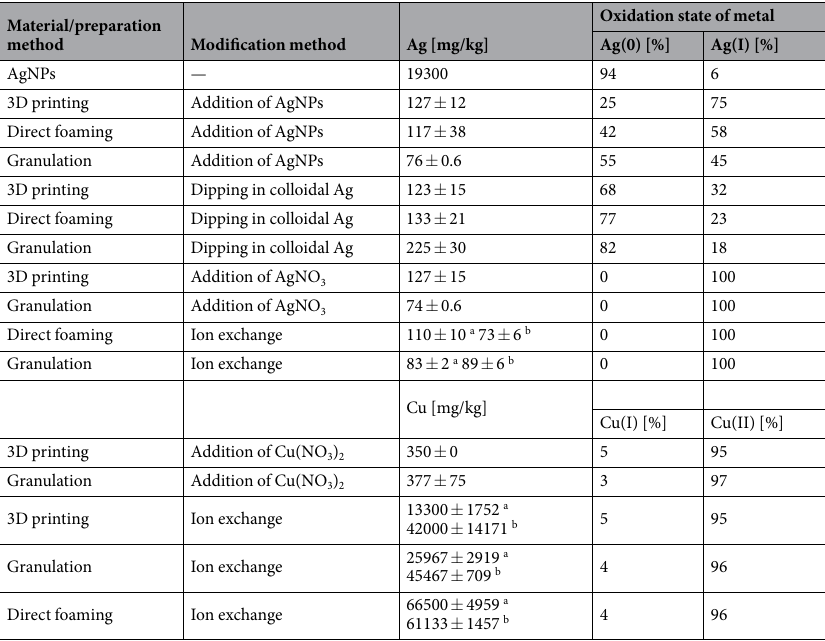
Table 2. Ag and Cu content and oxidation state in the modified filters, as determined by X-ray photoelectron spectroscopy (XPS) analysis. Metal content is expressed as an average of three measurements ± standard deviation. AgNPs = Ag nanoparticles; a = ion exchange from Na + to Ag + /Cu 2 + , b = ion exchange from Na + to NH 4 + and then to Ag + /Cu 2 +